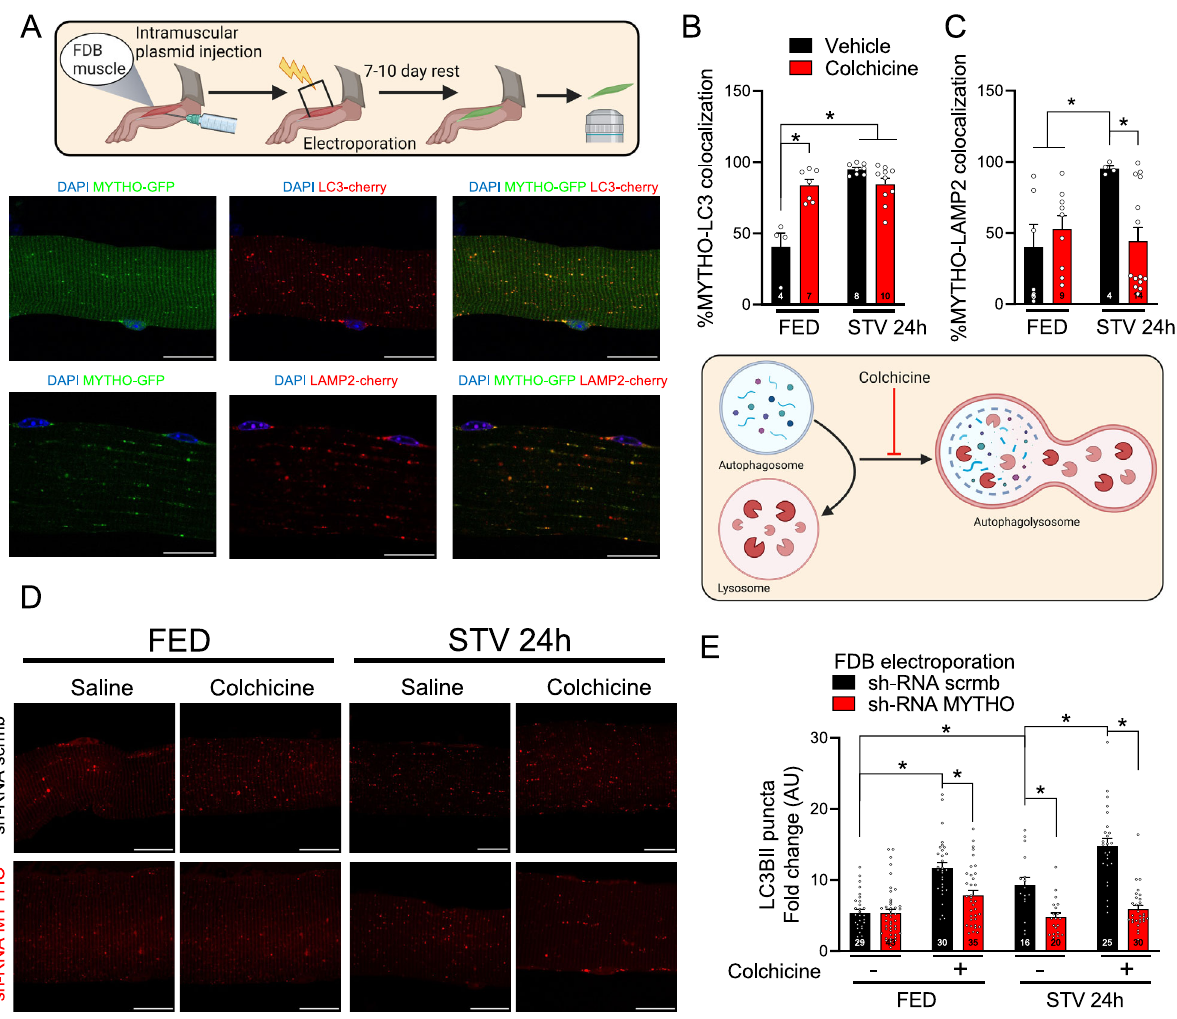
Fig. 2 | MYTHO is required for skeletal muscle autophagy. A Representative confocal microscope images were used for the quanti fi cation of the colocalization of MYTHO-GFP and cherry-LC3B(upperpanels)orMYTHO-GFP and LAMP2-cherry (lower panels) in isolated FDB muscle fi bers. Yellow dots highlight colocalization. Scalebar:20 µ m. B Quanti fi cationofMYTHOpositive punctathatco-localizes with LC3 in single- fi bers from mice treated with colchicine or vehicle in fed (FED) and 24h starved (STV). C Quanti fi cation of MYTHO-positive puncta co-localizing with LAMP2-cherry in fed (FED) and 24h starved (STV) mice that were treated with colchicineorvehicle. D RepresentativeimagesofsingleFDB fi